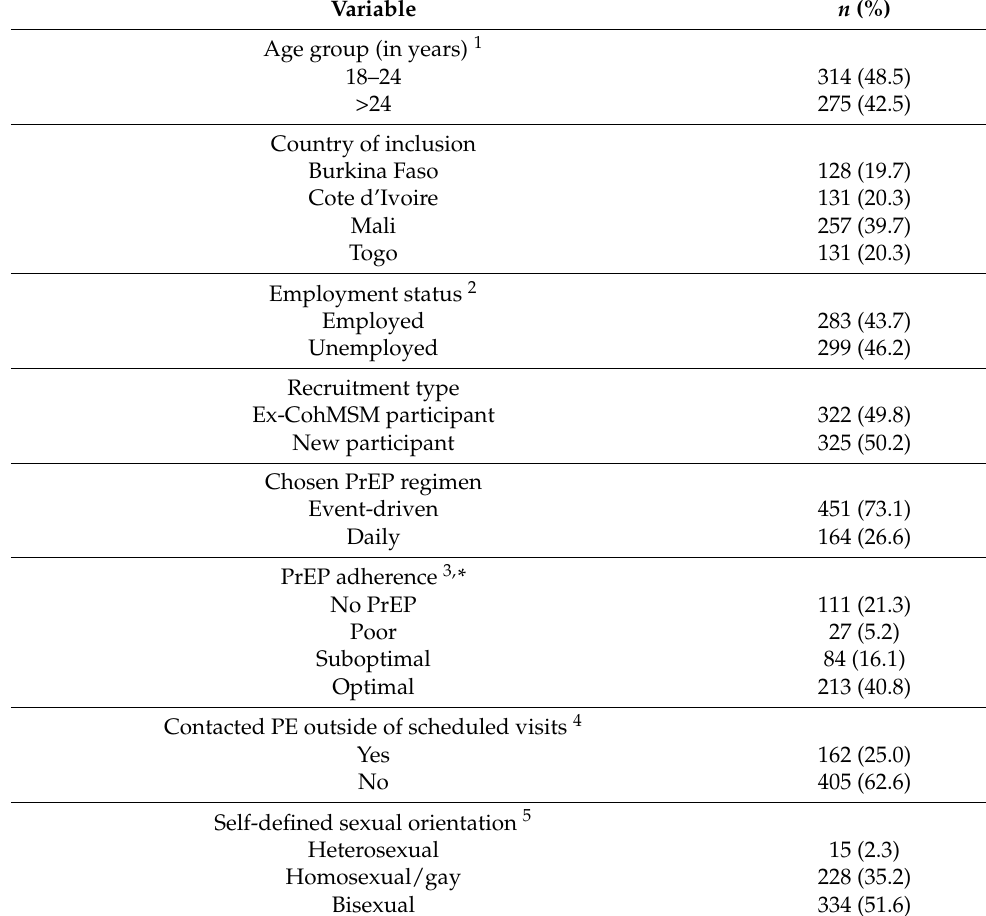
Table 1. Characteristics of study participants at baseline, n =